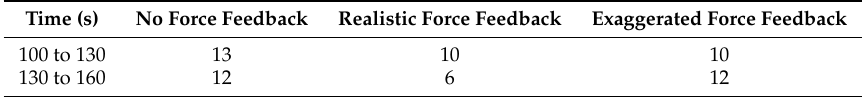
Table 6. Fall time, s ( t f ) at different time intervals.